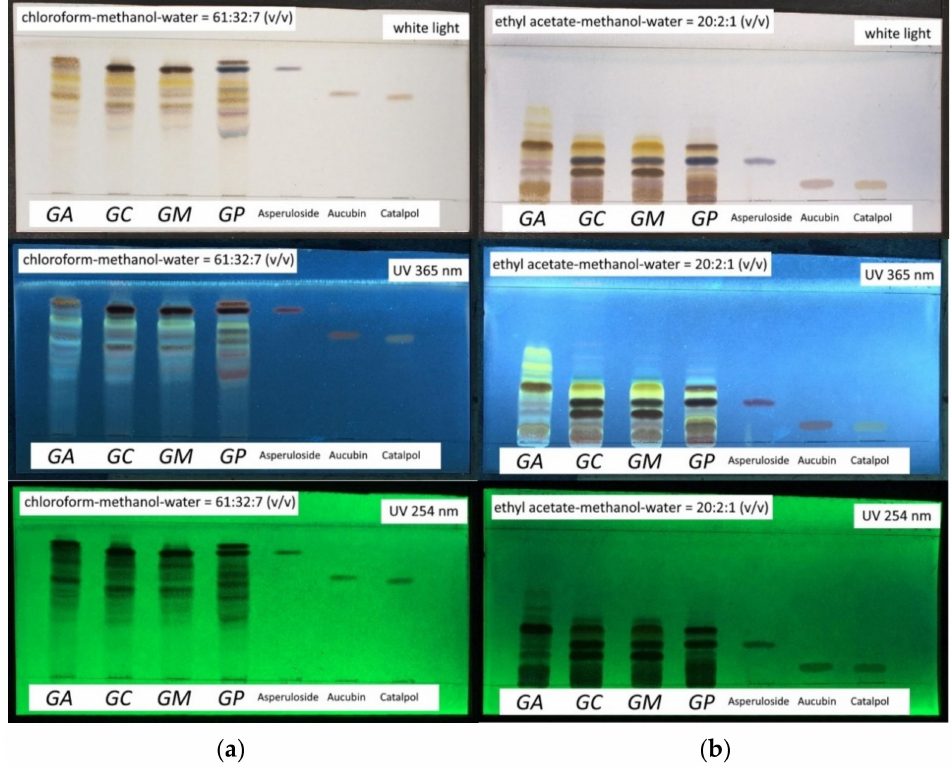
Figure 3. TLC chromatograms of Soxhlet extracts of aerial parts from G. alypum ( GA ), G. cordifolia ( GC ), G. meridionalis ( GM ) and G. punctata ( GP ) and asperuloside, aucubin and catalpol reference standard obtained after treatment with 1% ( w/v ) ethanolic vanillin-5% ( v/v ) ethanolic sulfuric acid reagent (5–10 min at 100–105 ◦ C), observed under white light, UV 365 nm and UV 254 nm. Stationary phase: silica gel 60 F 254 ; mobile phase: ( a ) chloroform-methanol-wate r = 61:32:7 ( v/v/v ); ( b ) ethyl acetate-methanol-wate r = 20:2:1 ( v/v/v